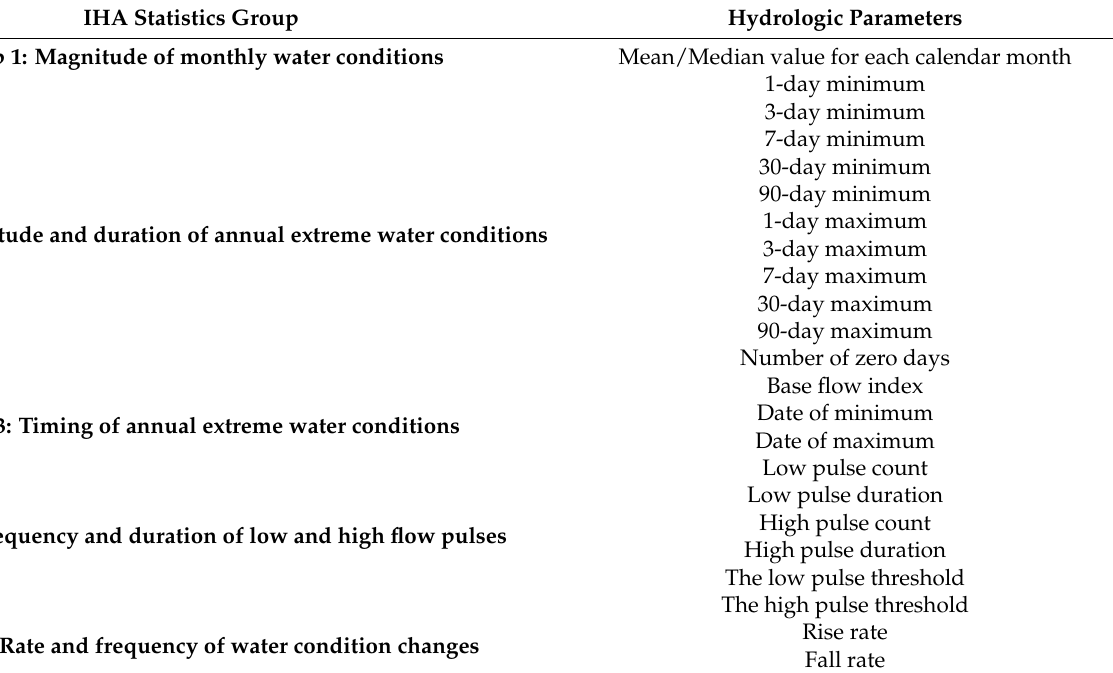
Table 3. Summary of hydrologic parameters analyzed by Indicators of Hydrologic